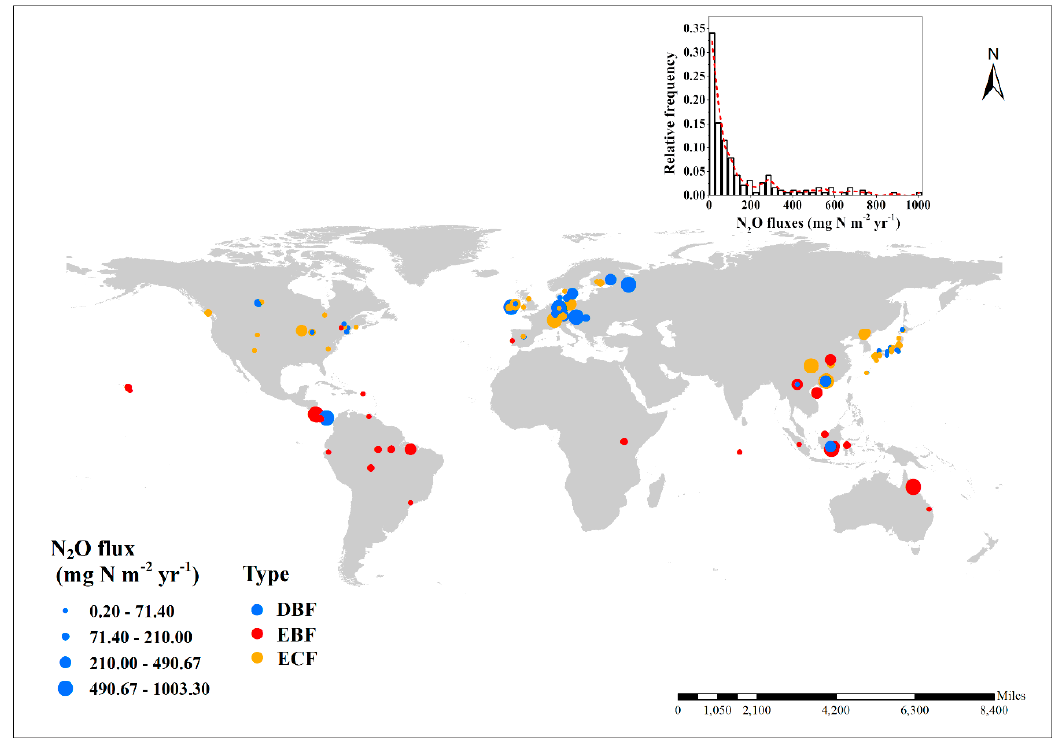
Figure 1. Geographic locations and vegetation types of study sites. The figure in the top right corner shows the relative frequency histogram of nitrous oxide (N 2 O) fluxes. DBF—deciduous broadleaved forests; EBF—evergreen broadleaved forests; ECF—evergreen coniferous forests.